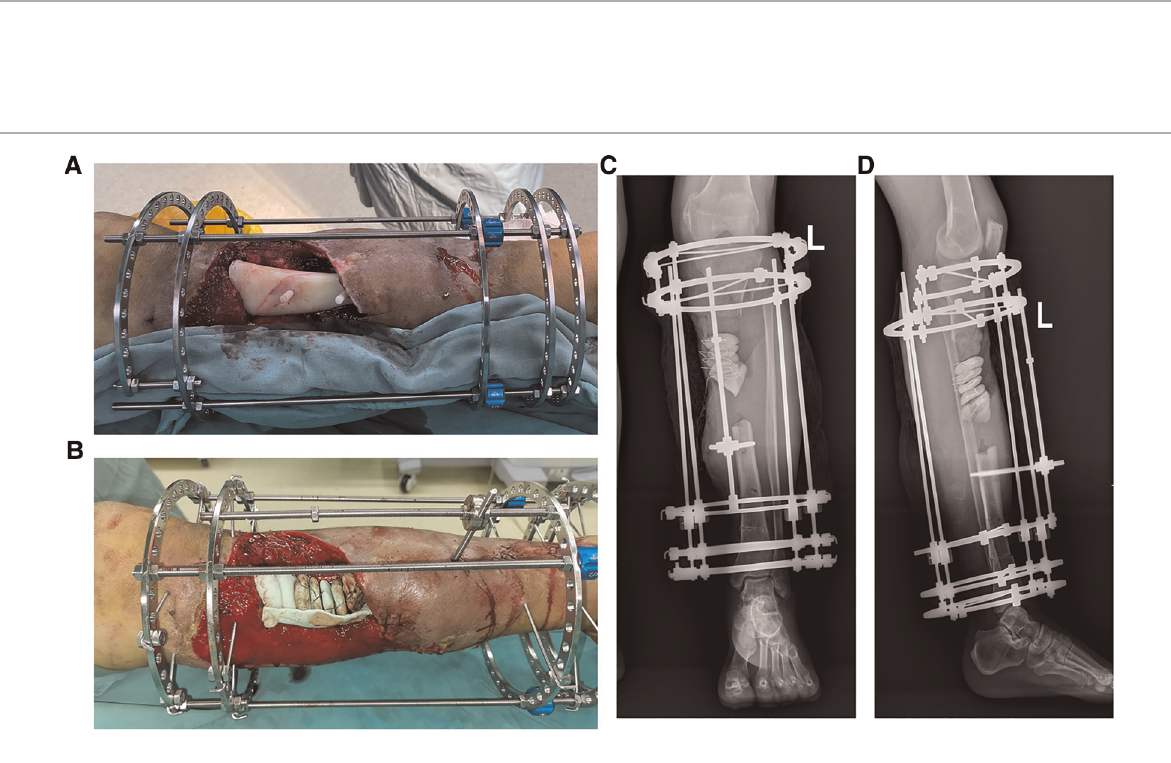
FIGURE 4 The intraoperative application of PSI and postoperative x-ray images in ilizarov technique of distraction osteogenesis in case 1. ( A ) The PSI was put into the bone defect to maintain the alignment of the fracture fragments. ( B ) Several pie-shaped bone cements were stacked into the defect which would be gradually withdrawn according to the bone transportation. ( C ) Postoperative x-ray on anterior-posterior (AP) view of case 1, the angulation of valgus is 1.74°. ( D ) Postoperative x-ray on lateral view after operation of case 1, the angulation of anteversion is 1.14°.